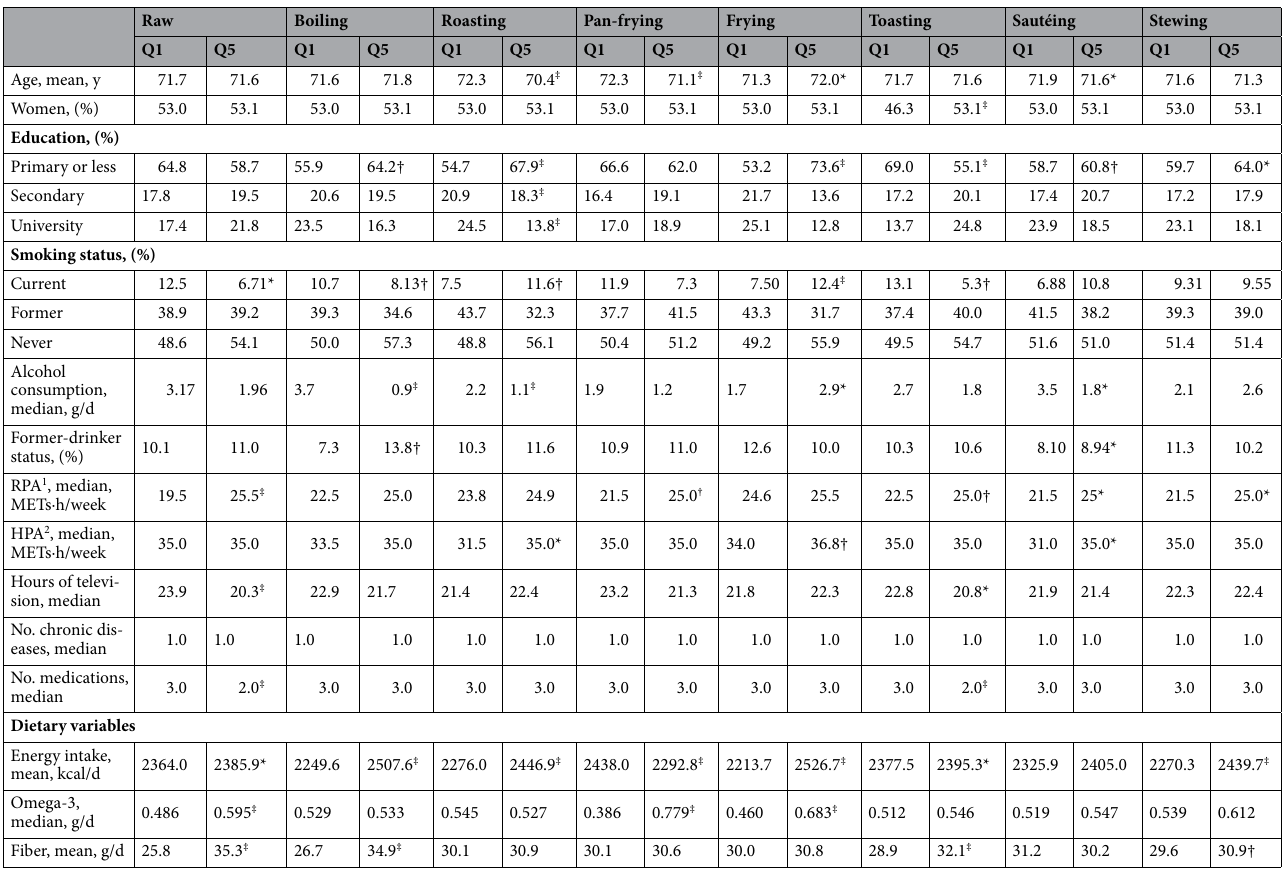
Table 1. Baseline characteristics of participants in extreme quintiles of cooking methods. The Seniors- ENRICA 2 Study (N = 2467). Q1 = Quintile 1 (lowest); Q5 = Quintile 5 (highest). Kruskal–Wallis test was used for comparisons between continuous variables and Pearson’s Chi-square for categorical variables. 1